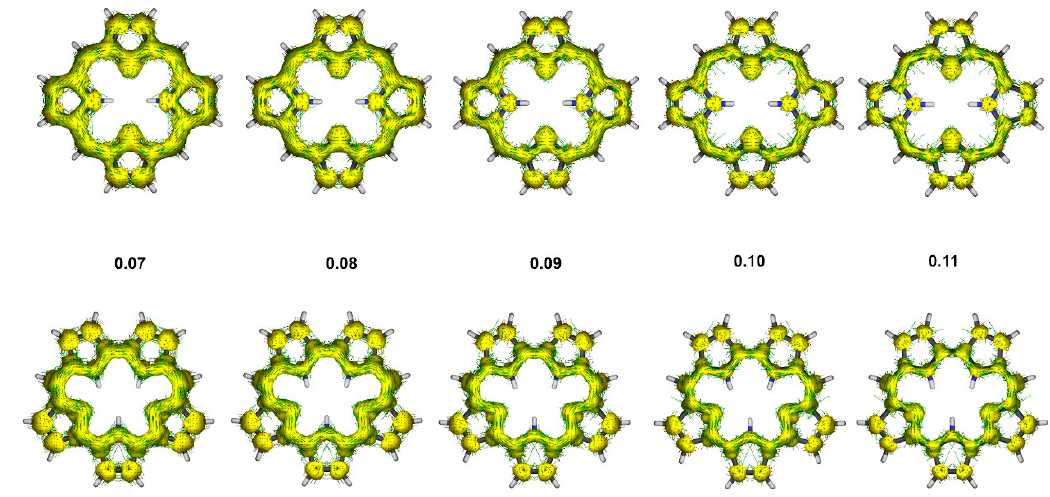
Figure 4. AICD plots of (18)porphyrin ( top ) and (20)orangarin ( bottom ) for different isosurface values (in a.u.).